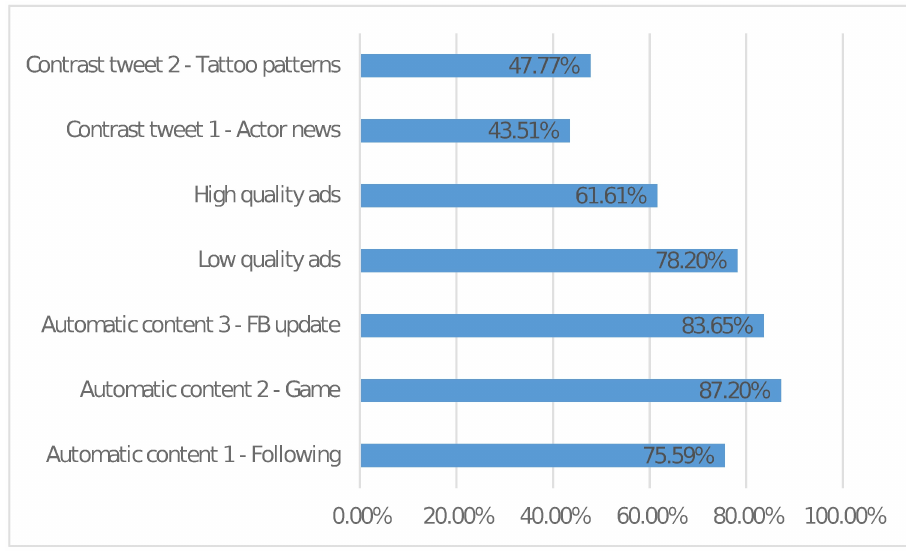
Fig 4. Users’ definition for low-quality content (Specific